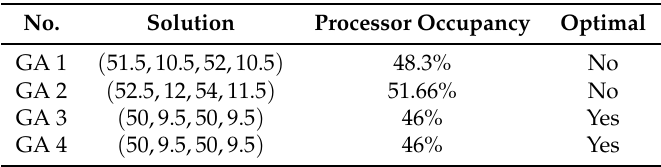
Table 4. Optimization result of Experiment 1.